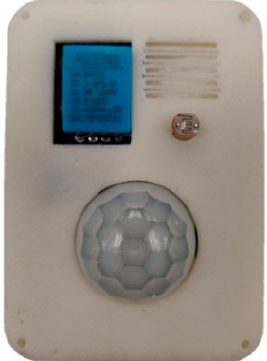
Figure 7. LiB prototype for occupancy monitoring.